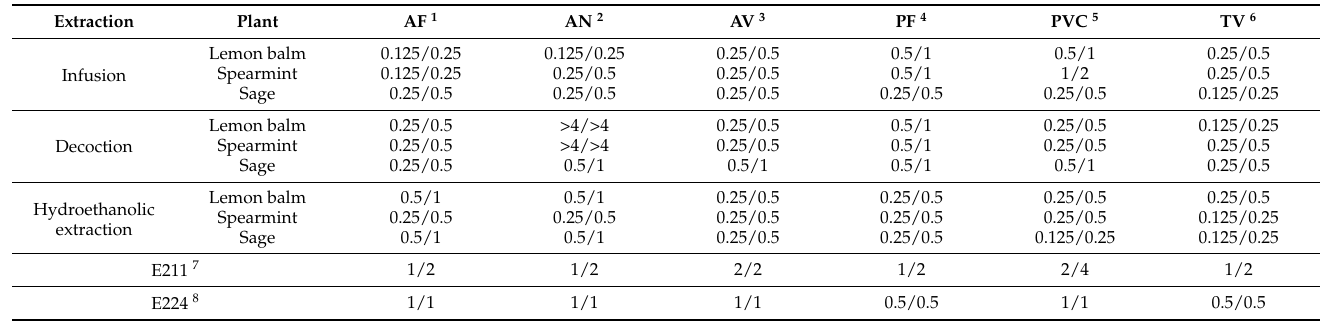
Table 2. Antifungal activity of plant extracts expressed as minimum inhibitory and minimum fungicidal concentration, MIC/MFC, respectively (mg/mL; mean ± SD, n =